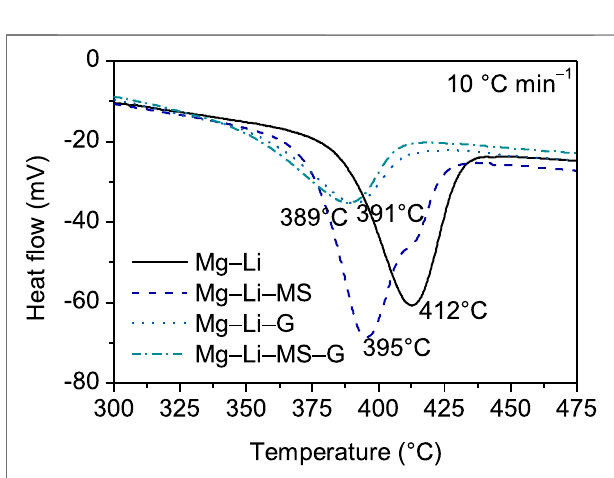
FIGURE 4 | Isothermal dehydrogenation curves of the Mg − Li, Mg − Li − MS, Mg − Li − G, and Mg − Li − MS − G composites at a constant temperature of 325 °